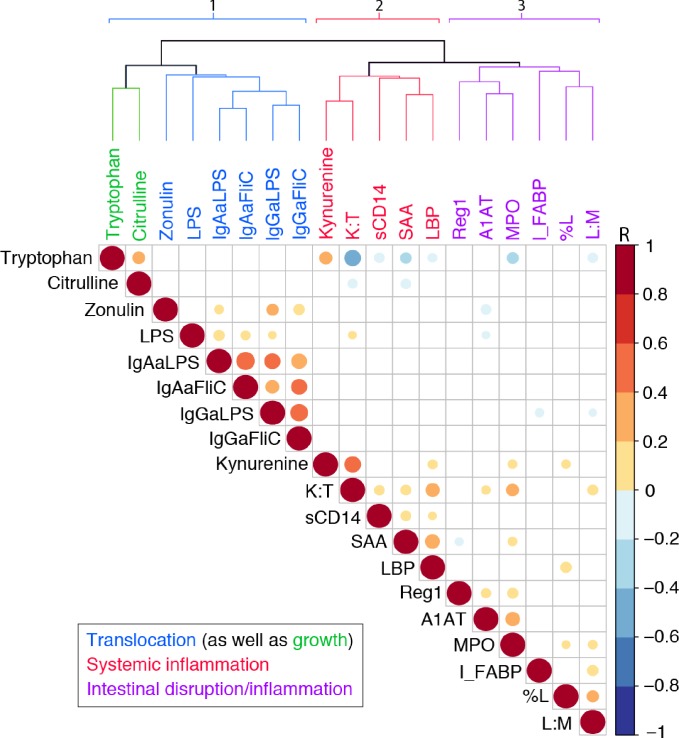
Cluster dendrogram with Pearson correlations among those biomarkers with ≥274 values showing three main groups: 1) translocation markers, LPS and IgA and IgG anti-LPS or FliC as well as zonulin and the 2 potential predictors of subsequent growth, tryptophan and citrulline; 2) predominantly systemic responses to disrupted barrier function and translocation; and 3) markers of specific intestinal barrier disruption or local intestinal inflammation.As discussed, groups 1 and 3 may predispose to group 2 systemic responses in associating with each other as shown in the heat map as would fit our concept of the pathogenesis of enteropathy.